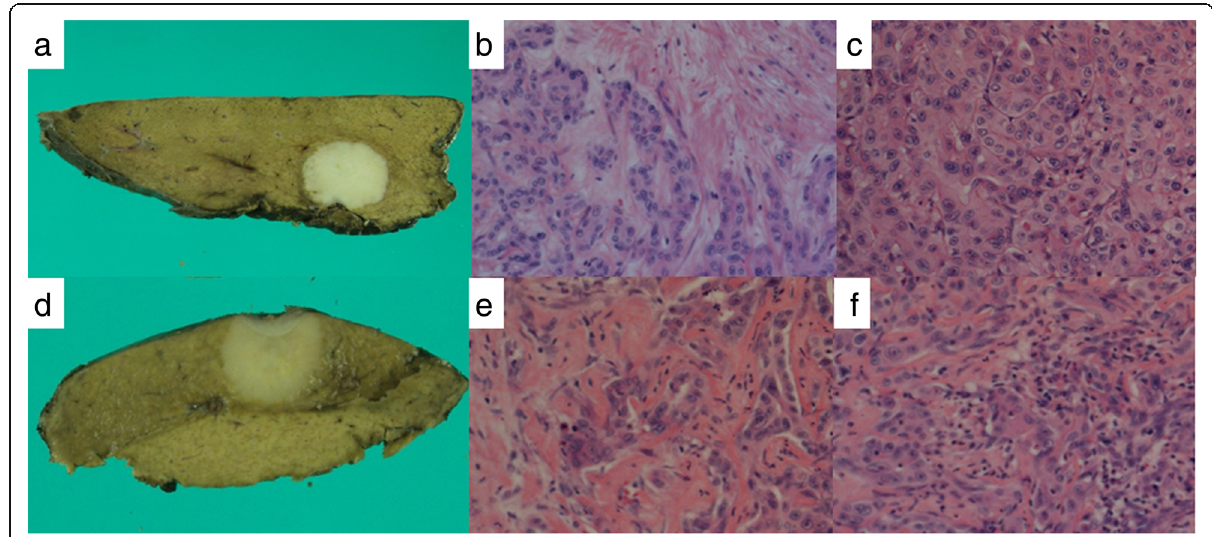
Fig. 4 The cut surface of the resected specimen shows a gray-white nodular lesion in hepatic S4/S8 ( a ) and S7 ( d ). Microscopic findings show moderately differentiated adenocarcinoma in the center of the tumor ( b , e ) and poorly differentiated adenocarcinoma at the margin of the tumor ( c , f ). b , c , e , f Hematoxylin and eosin staining, ×